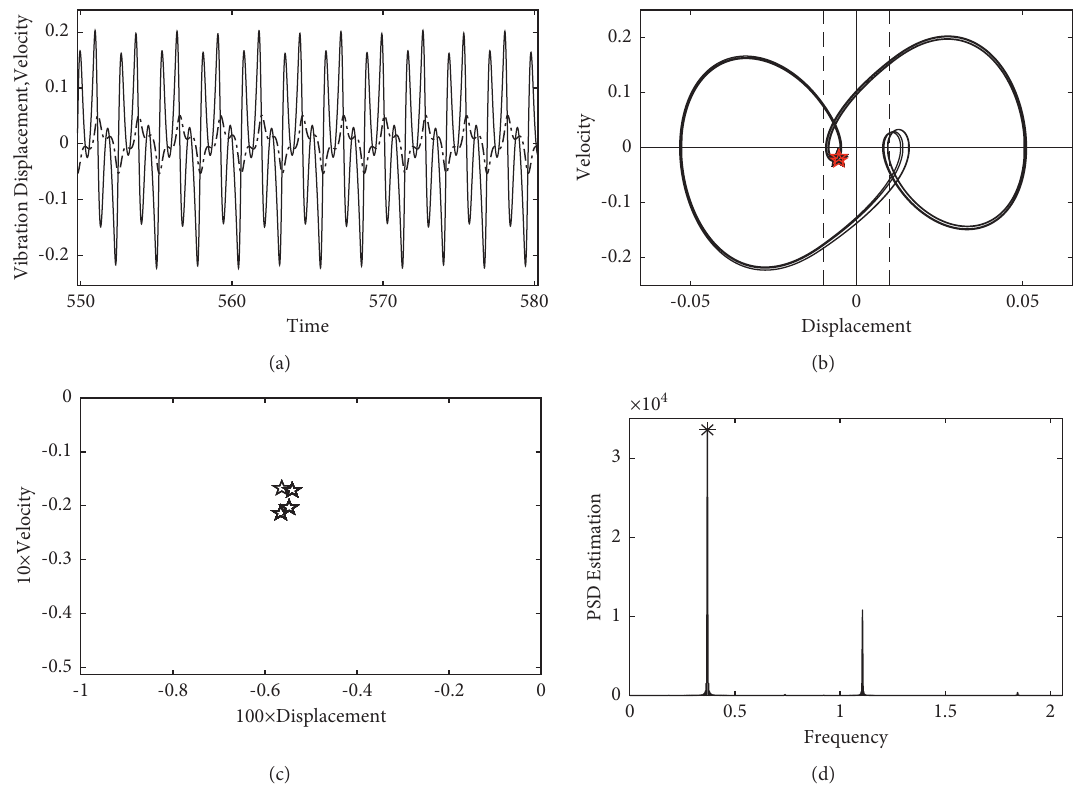
Figure 14: f � 0 . 3688Hz, asymmetric period 4-4-8. (a) Time history graph. (b) Phase diagram. (c) Poincar´e section. (d) Power spectral density